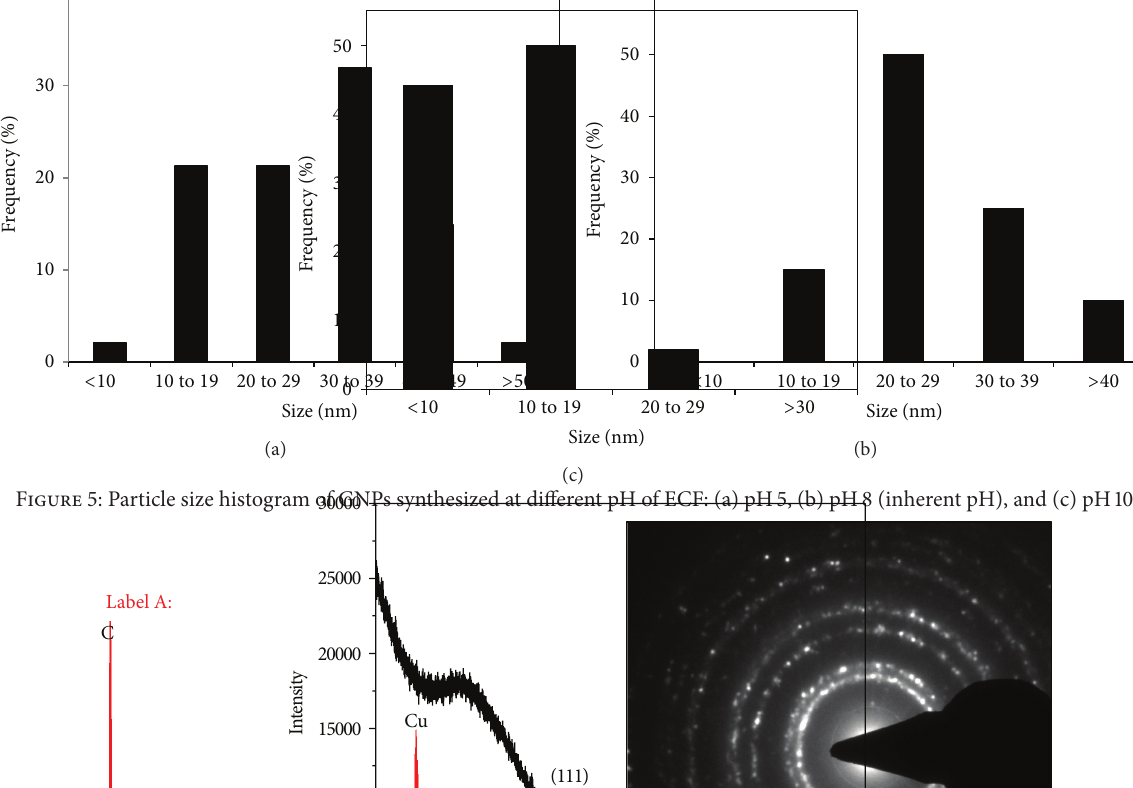
Figure 4: TEM micrographs of synthesized GNP at different pH of ECF: (a) pH 5, (b) pH 8 (inherent pH), and (c) pH 10.